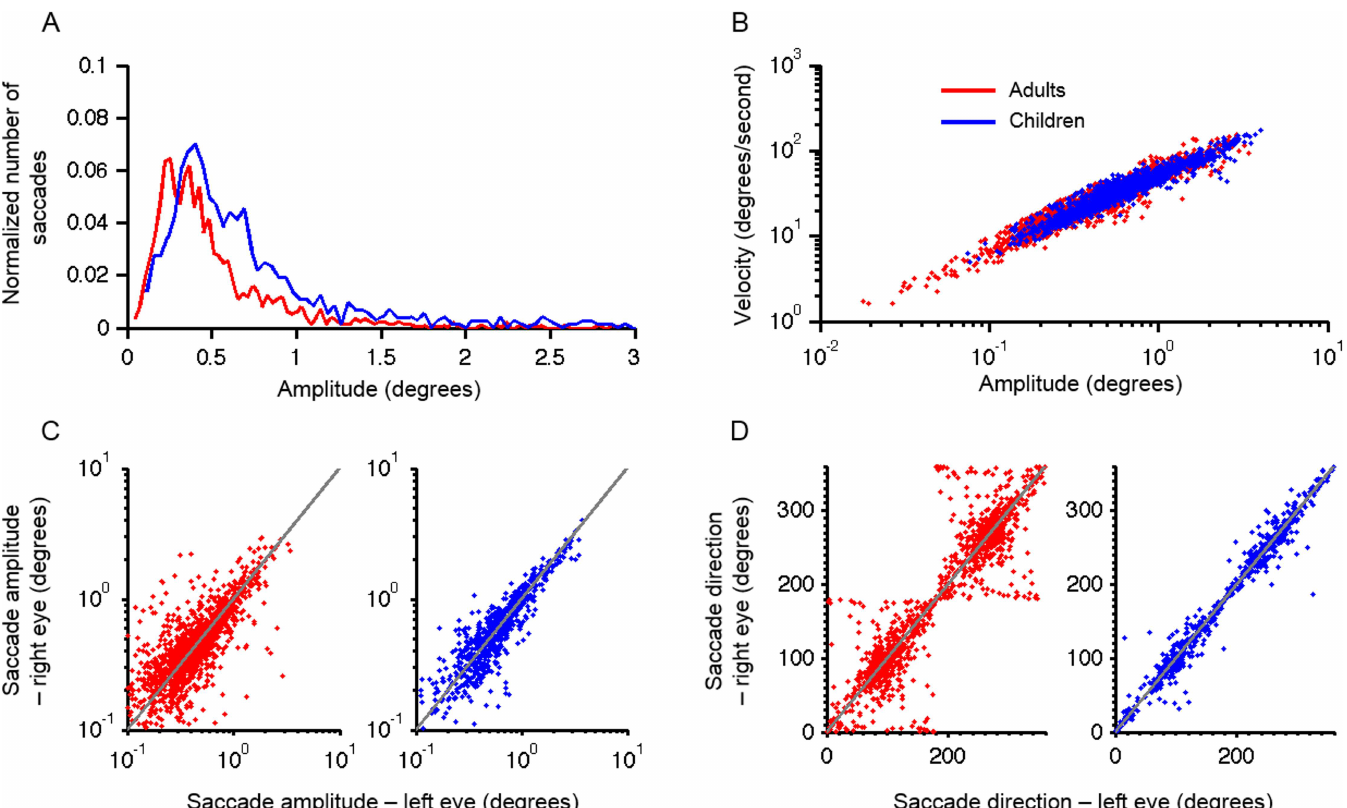
Fig 2. (A) Distributionof microsaccade amplitude, when saccades were identifiedusing clusteringalgorithmproposed by Otero-Millan et al. (2014). A normalized numberof microsaccades are plotted on the y-axis, while x-axis depicts the amplitudeof microsaccades in degrees. Red lines depict the distribution of microsaccades in adults, whileblue lines depict children. The two distributionswere significantly different (Two-sampleKolmogorov-Smirnov test p < 0.0001). (B) Kinematicpropertiesof microsaccades quantified in the main-sequence analysis. Eye velocitiesare plotted on the y-axis whilethe corresponding positionsare plotted on the x-axis. Each data point depicts one saccade. Blue symbols illustrate children,while red data points are adults. (C) Comparison of the amplitudedisconjugacy and (D) directionaldisconjugacy of fixational saccades. In both panels, the right eye is plotted on y-axis whilethe left eye is plotted on the x-axis. Red symbols depict adults, whilechildrenare shown in blue data points. Grey line is an equalityline. The red points, suggesting adults, have larger scatter showingmore amplitudeand directional disconjugacy comparedto pediatricpatients.